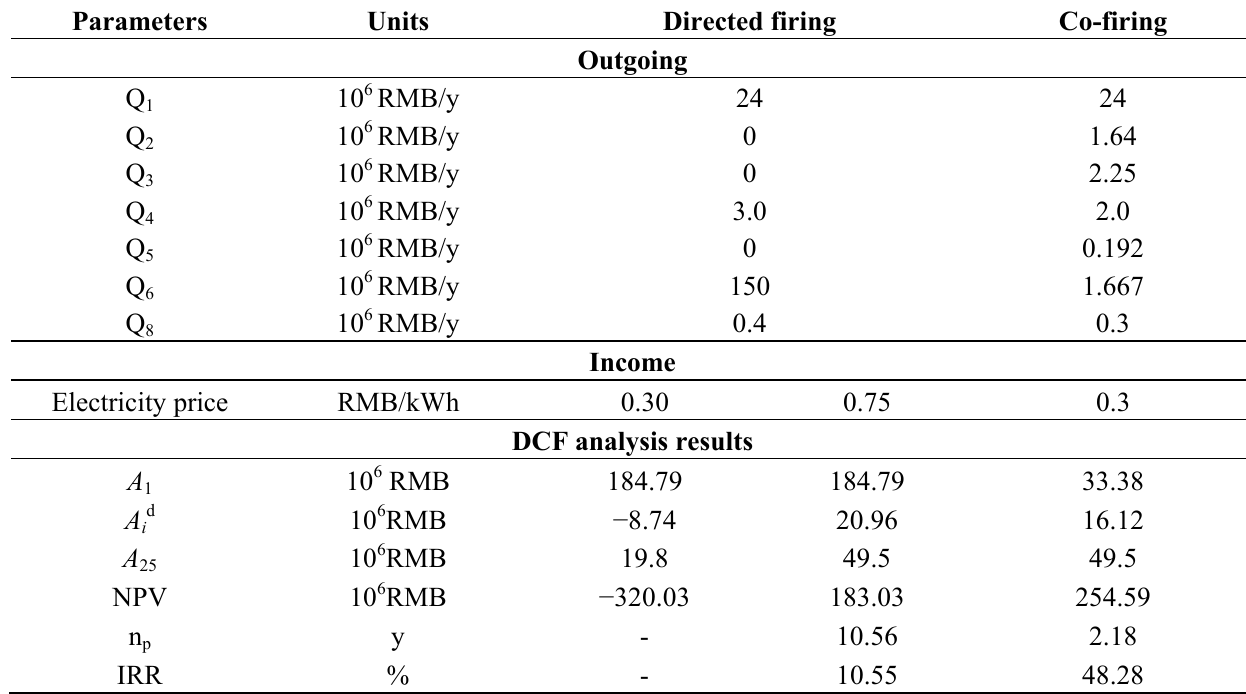
Table 6. Summary of various parameters of dedicated biomass firing and